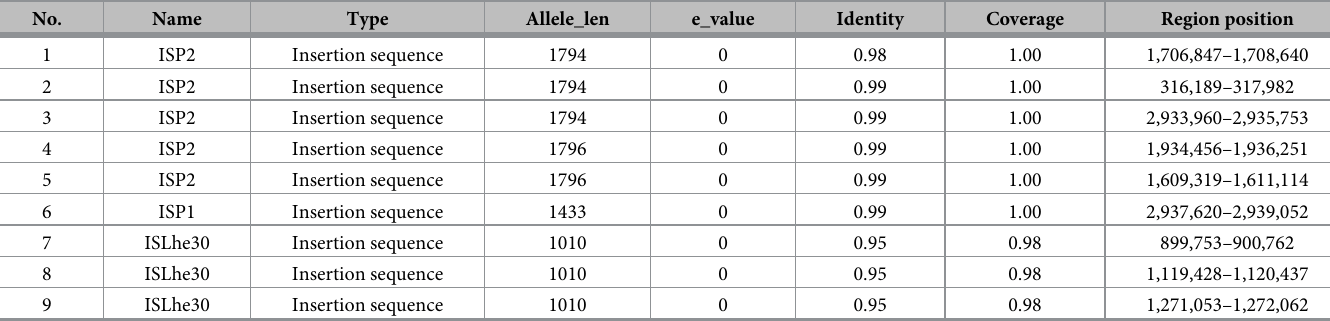
Table 6. List of mobile element regions in the genome of Lactiplantibacillus plantarum PMO 08 predicted by mobile genetic finder.